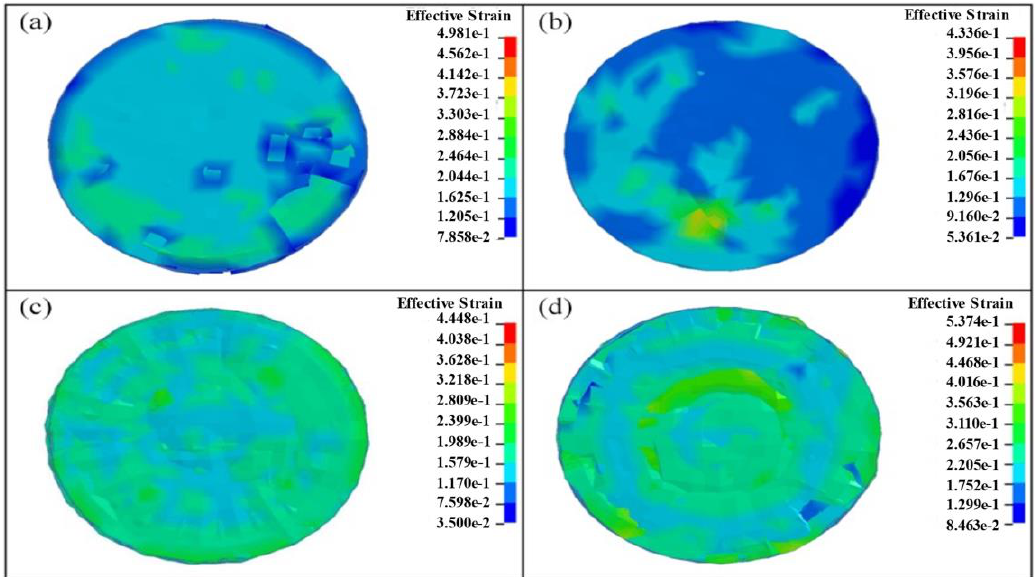
Figure 7. The deformation degree of Ti layer in Ti–Al3Ti–Al laminated composites with different Al contents: ( a ) 0% Al, ( b ) 10% Al, ( c ) 20% Al, ( d ) 30%.